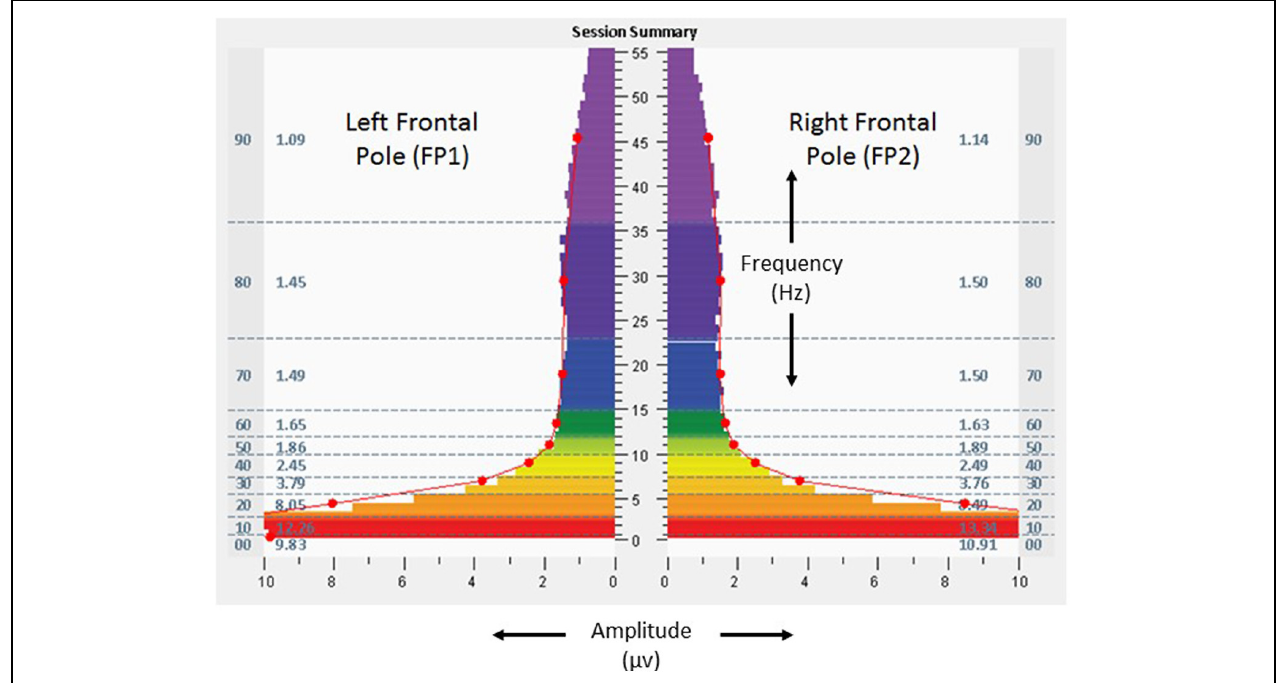
FIGURE 2 | Fast Fourier Transform spectral display of 1 min recording of brain electrical activity at left and right frontal poles (FP1 left, FP2 right), with eyes open, during the baseline assessment, from the 18-years-old learner described in the text. Individual color bars reflect amplitude averages for 1 min of recording, eyes closed, at rest, without